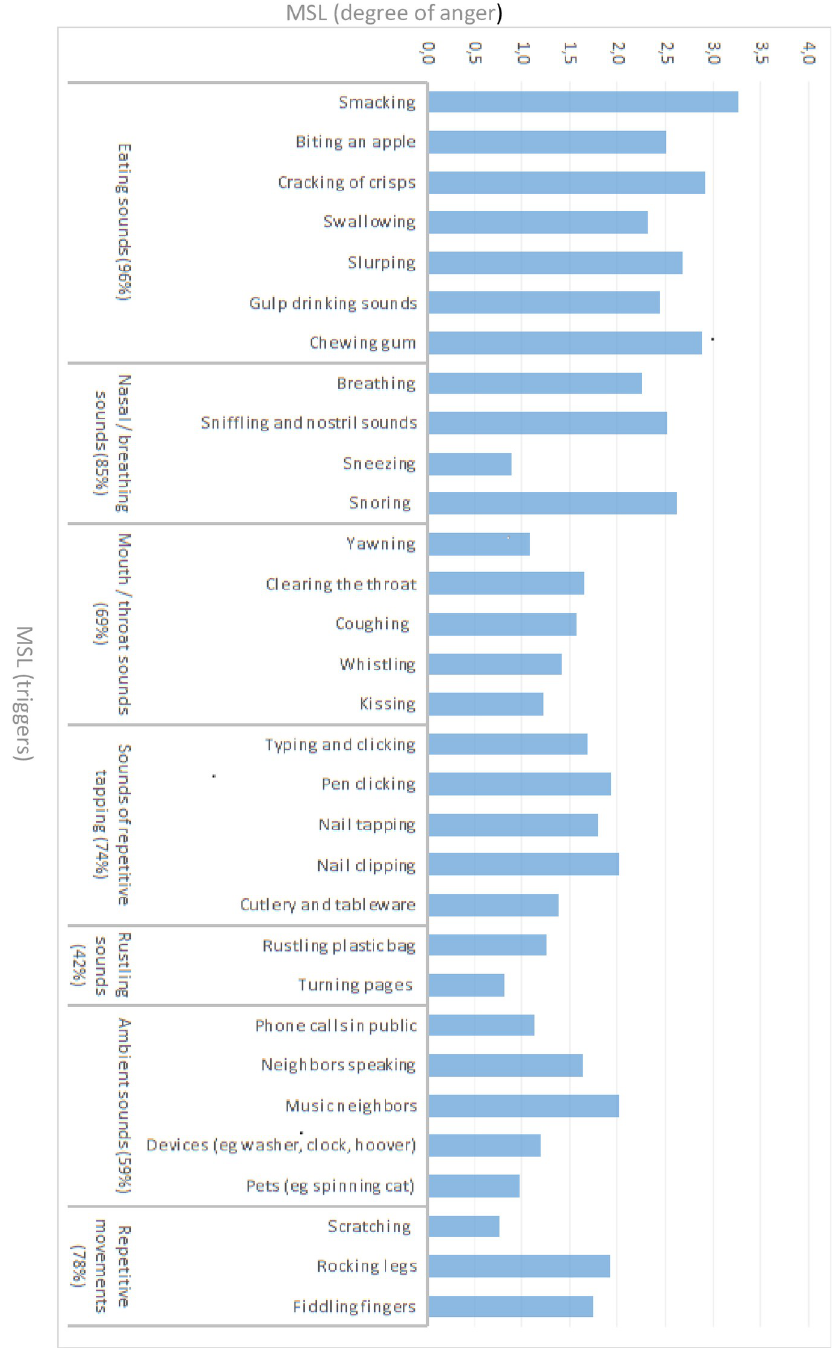
Fig 1. Triggers and provoked anger for misophonia